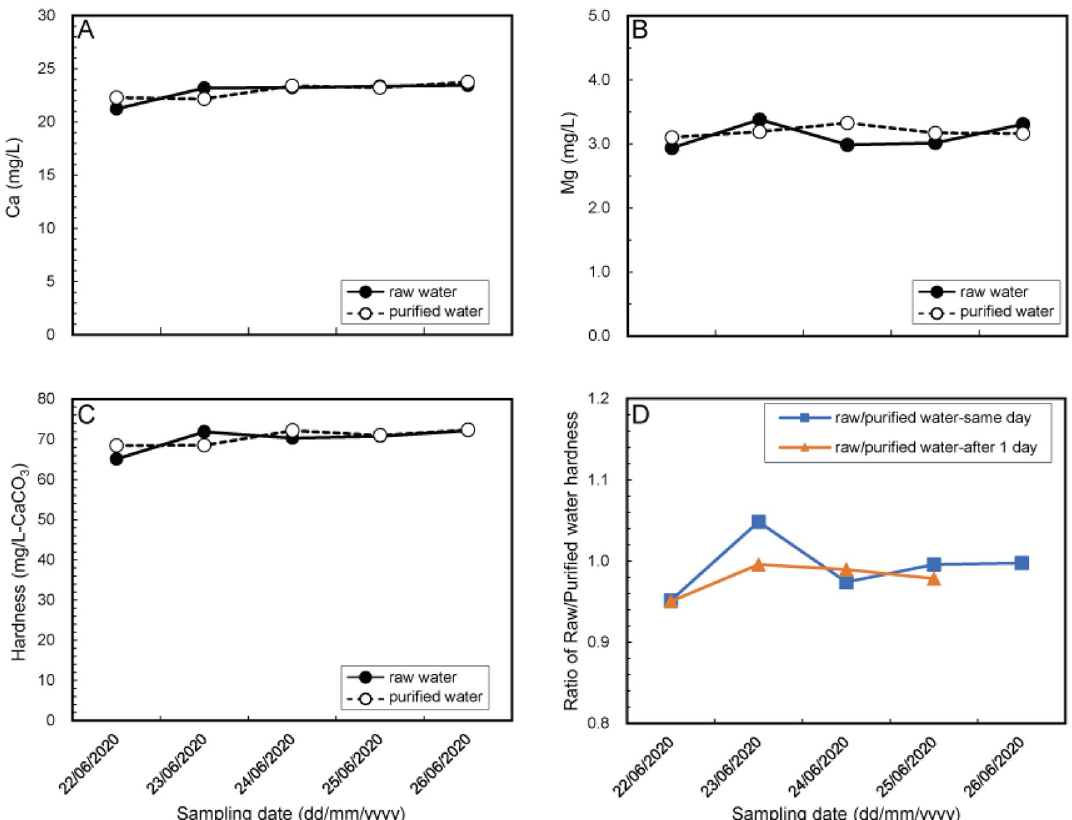
Figure 5. Daily changes in ( A ) Ca, ( B ) Mg, and ( C ) water hardness concentrations in raw and purified water at the Asaka Water Purification Plant. ( D ) Ratio of raw/purified water hardness (R/P ratio). Blue line and squares indicate the R/P ratio, raw and purified water collected on the same day. The orange line and triangles indicate the ratio of raw water, and purified water 1 day later considering the purification